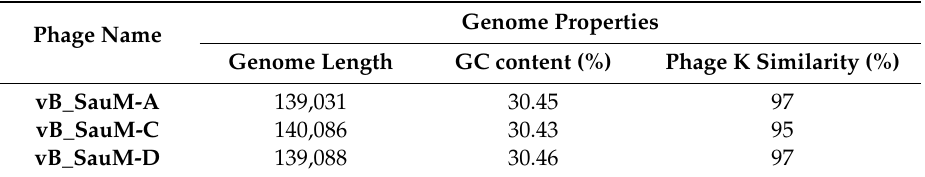
Table 5. Bacteriophages genomes